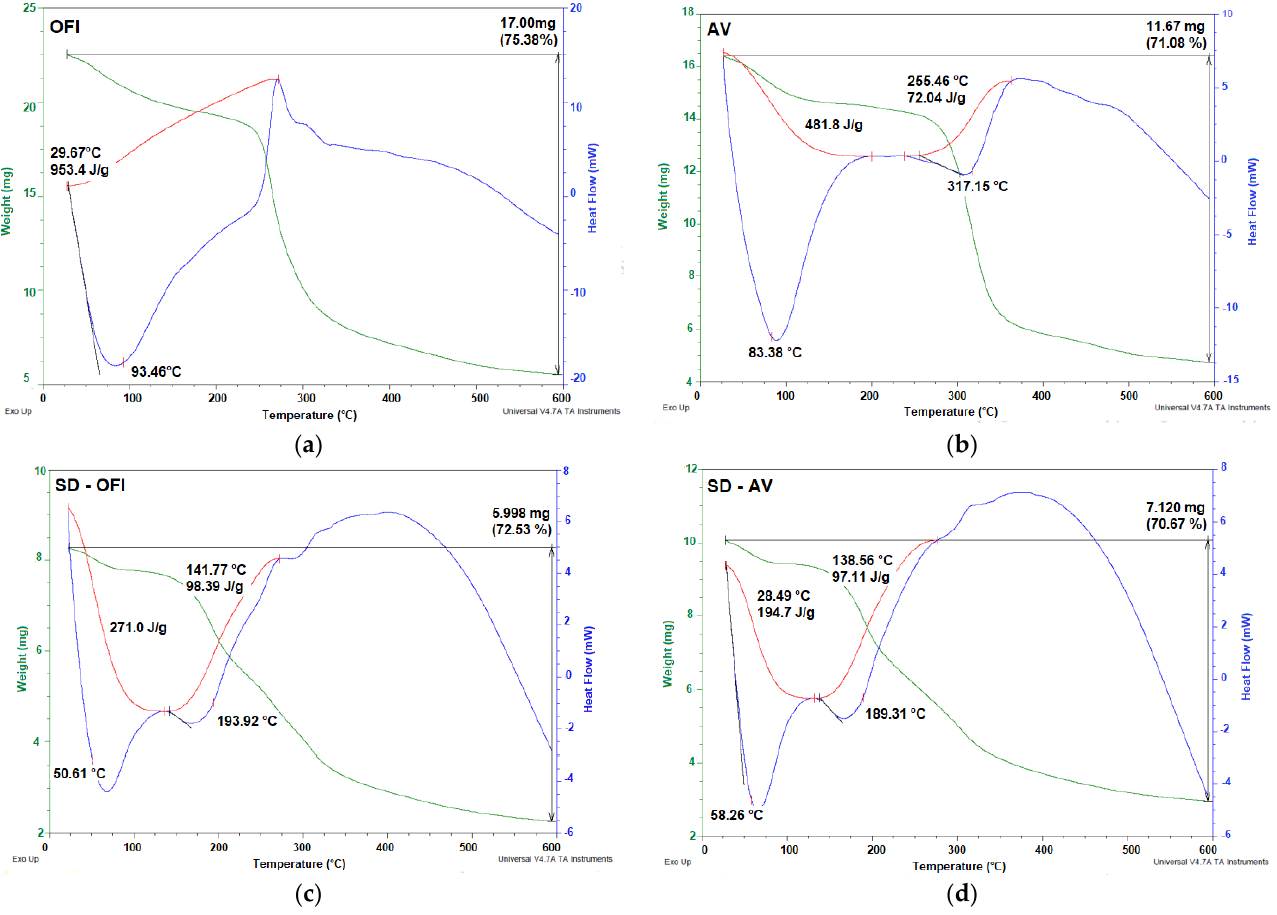
Figure 6. TGA/DSC thermograms of OFI ( a ) and AV ( b ) mucilages, and SD-OFI ( c ) and SD-AV ( d ) microcapsules.